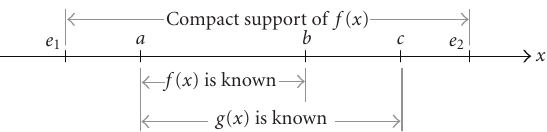
Figure 2: Setting for Theorem 2, where f ( x ) is supported on [ e 1 , e 2 ] and known on ( a , b ), while its Hilbert transform is known on ( a , c